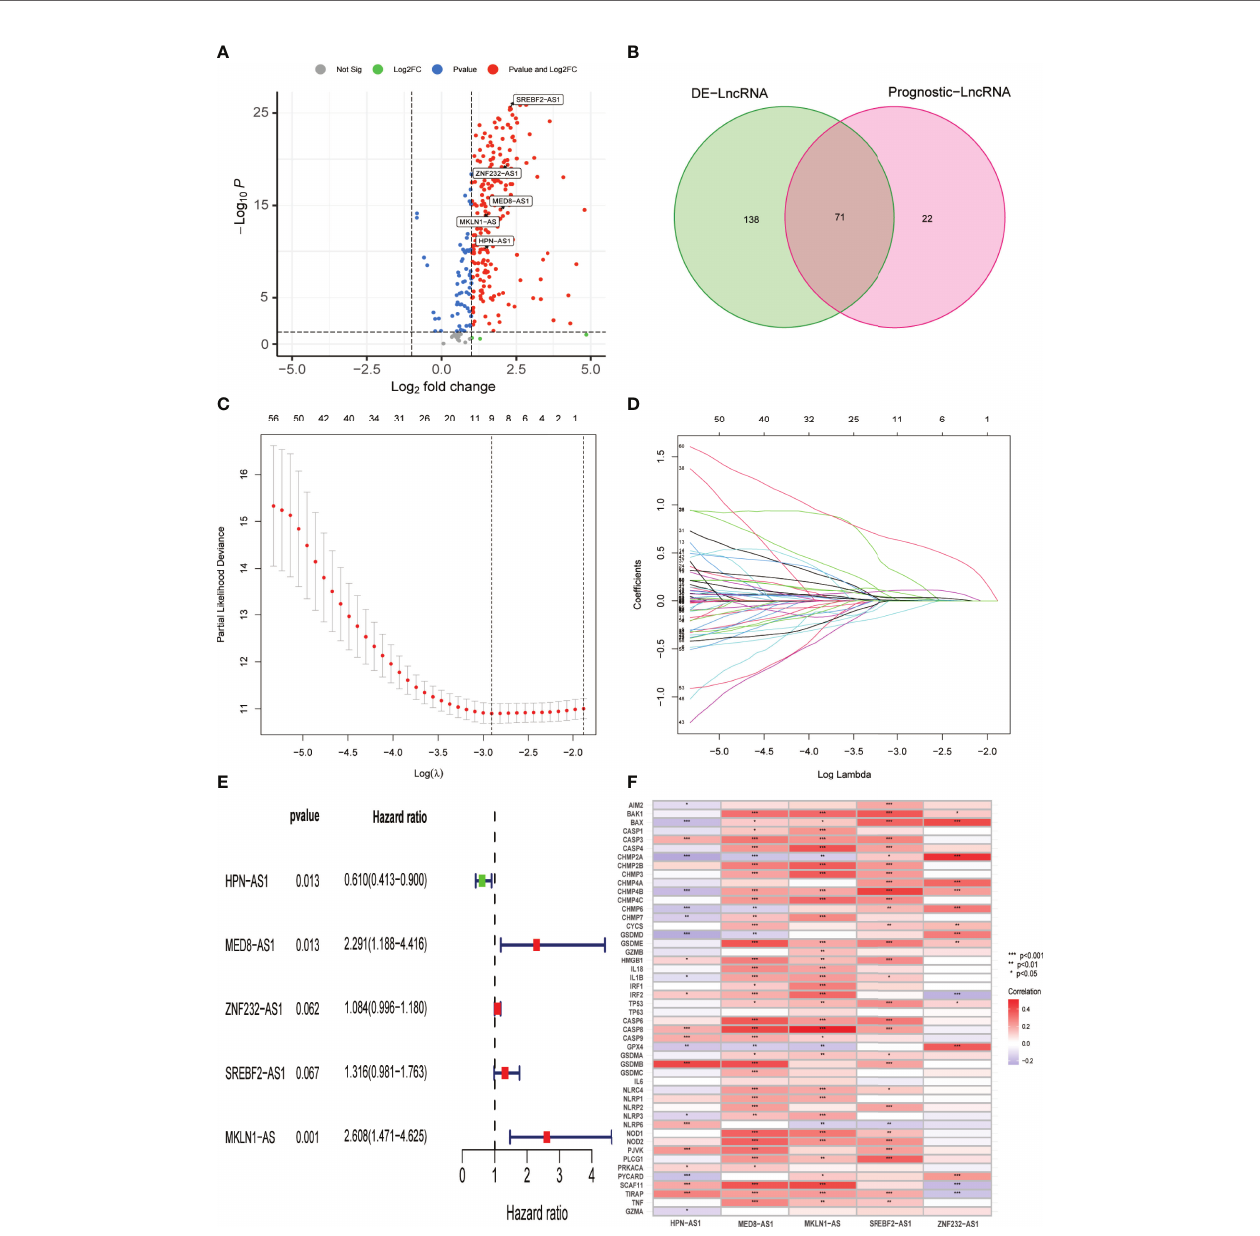
FIGURE 3 | Establishment of the PR-lncRNA prognostic signature for HCC patients. (A) Volcano plot of differentially expressed PR-lncRNAs in HCC from entire set. (B) Venn diagram to identify differentially expressed PR-lncRNAs associated with prognosis. (C, D) Ten-fold cross-validation by the LASSO Cox regression for the prognostic value of the PR-lncRNAs in the training set. (E) The presentation of fi ve lncRNAs in multivariate Cox regression analysis. (F) Representation of the correlations between 52 PRGs and the fi ve prognostic PR-lncRNAs via